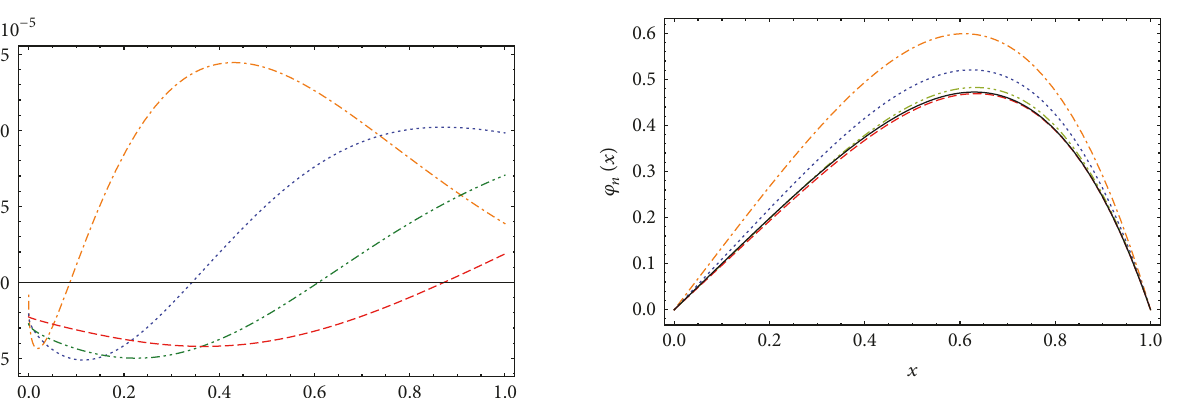
Figure 9: 𝜑 𝑛 (𝑥) when 𝑛 = 10 obtained by the Duan-Rach modified ADM for 𝛼 = 3.2 (dot-dash), 𝛼 = 3.4 (dot line), 𝛼 = 3.6 (dot-dot- dash), 𝛼 = 3.8 (dash line), and 𝛼 = 4 (solid line).